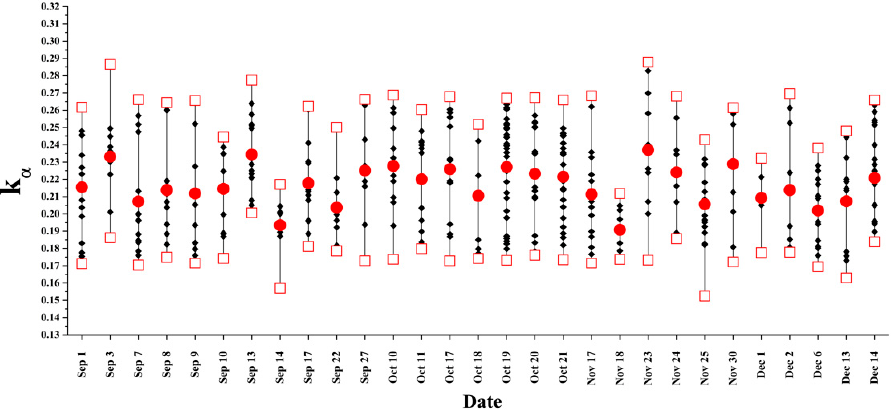
Figure 8. Statistical chart of daily conversion factors. The black dots are the conversion factors in each day, temporal resolution is 10 min, two hollow square dots located on the top and bottom are the maximum and minimum, respectively, for each day, and the red solid dots represent the mean conversion factor for each day.